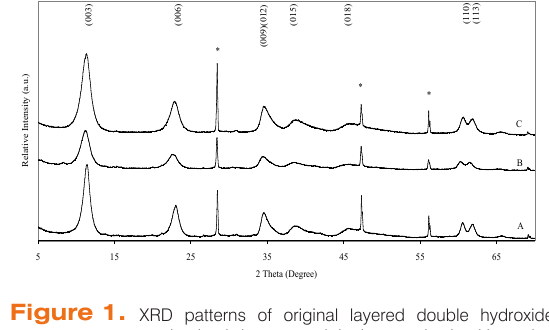
Figure 1. XRD patterns of original layered double hydroxides synthesized by coprecipitation method with various cations composition. A – Mg/Al; B- Mg/Co/Al; C- Mg/Ni/ Al. Reflections from Si crystal used as a reference are marked with asterisk.